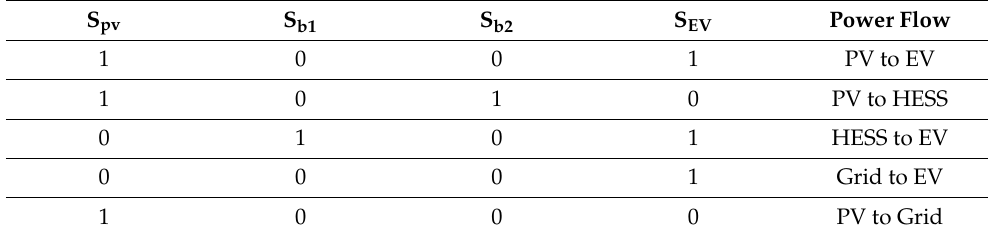
Table 1. EV Charging Operating Modes.